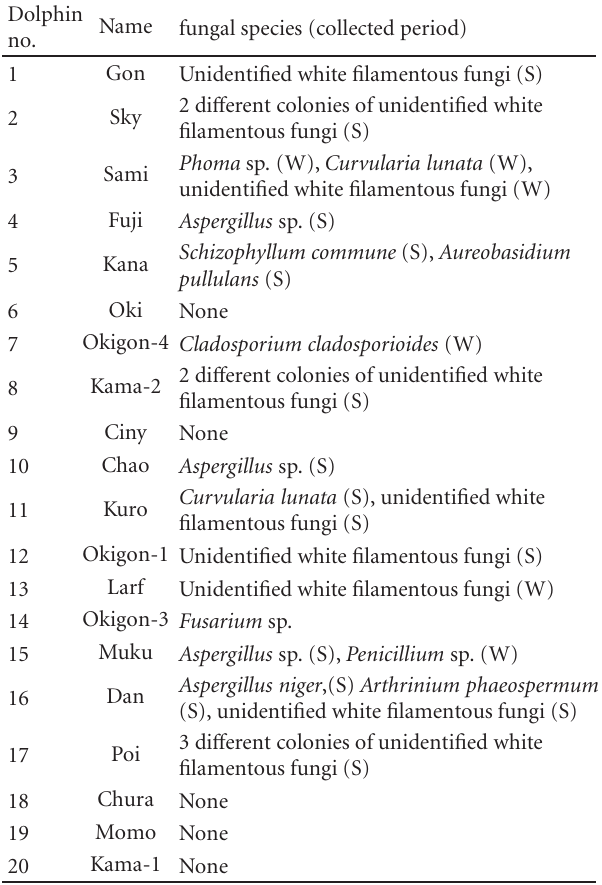
Table 3: Mycelial fungal species isolated from